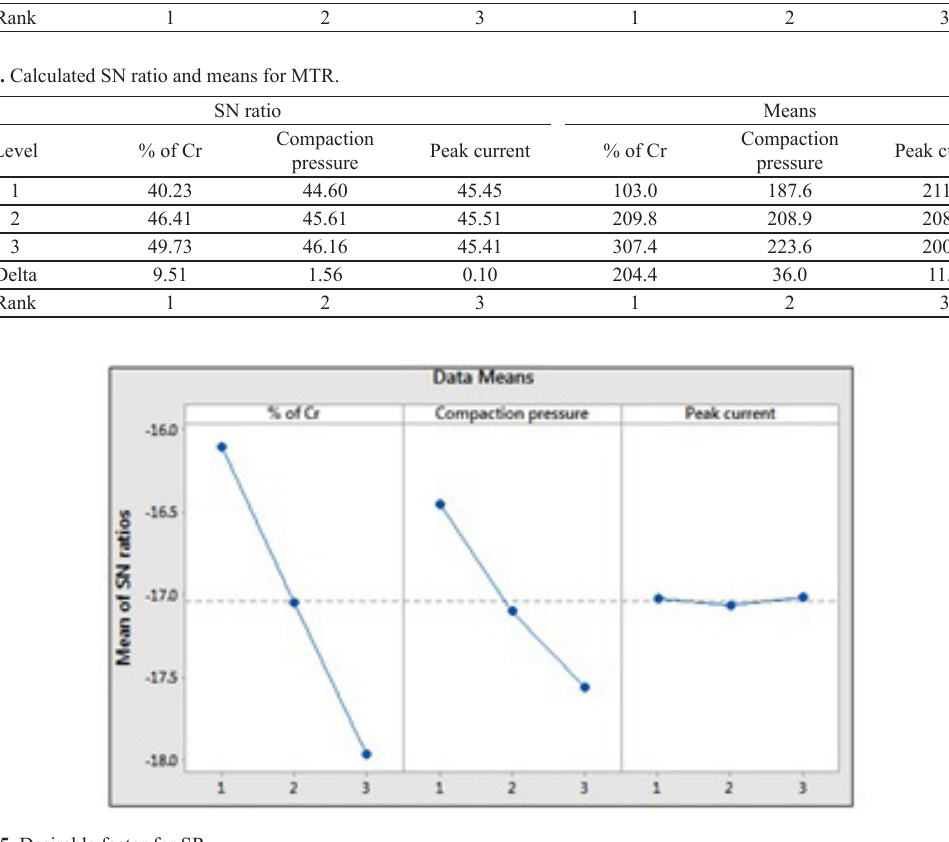
Figure 5. Desirable factor for